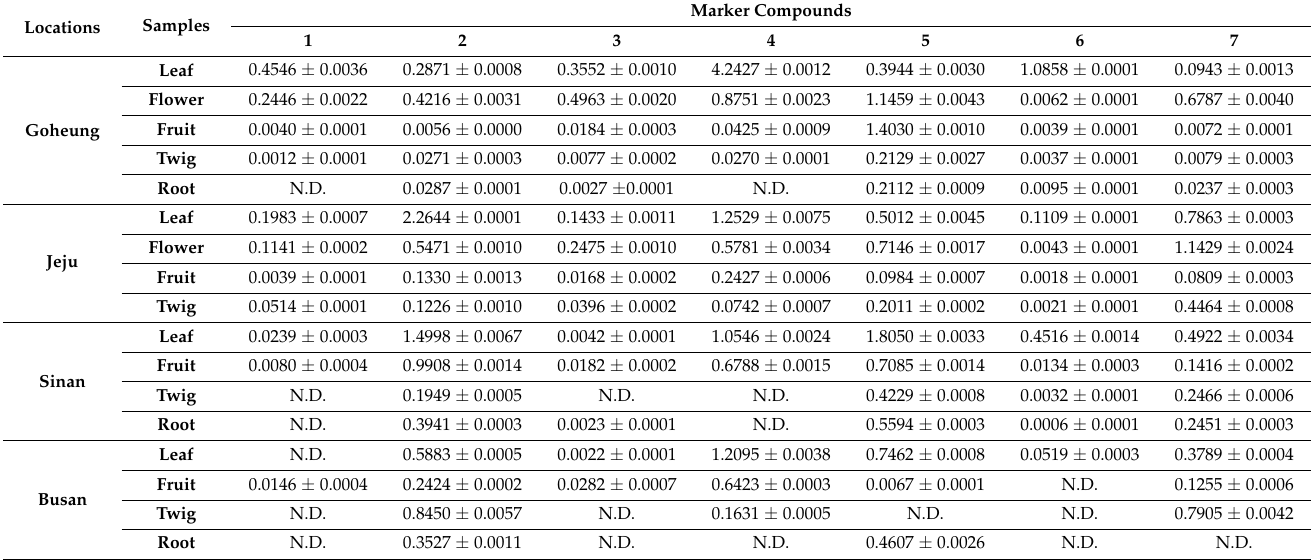
Table 3. Quantification of marker compounds content in the organs of V. rotundifolia collected at different